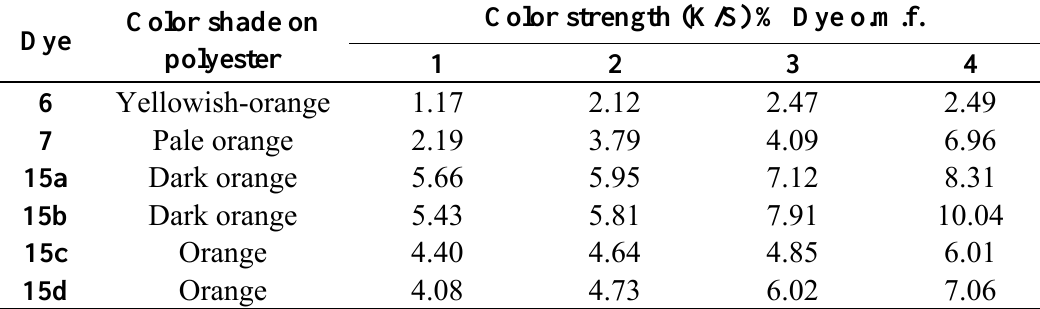
Table 1. Color strength of dyed polyester using high temperature dyeing